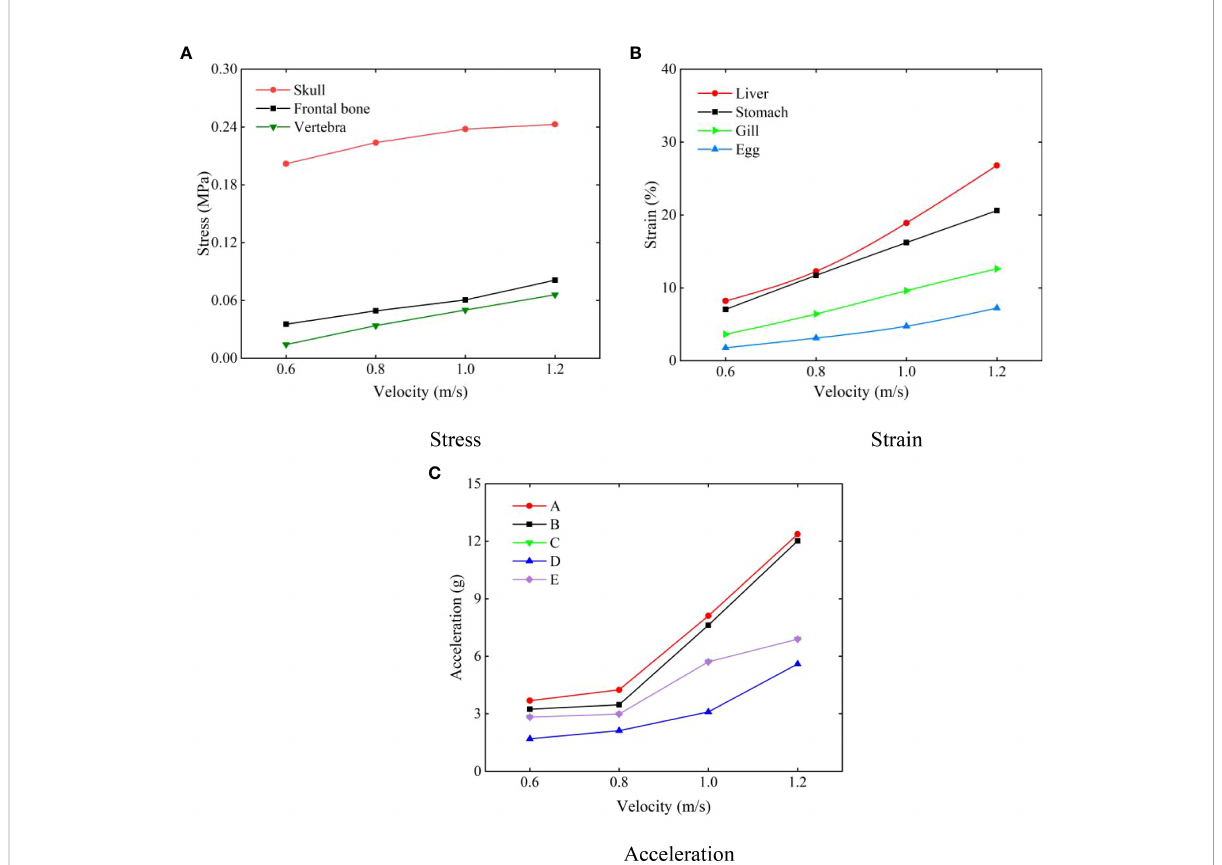
FIGURE 11 Response curves of various tissues and organs at different collision speeds (A) stress; (B) strain; (C)